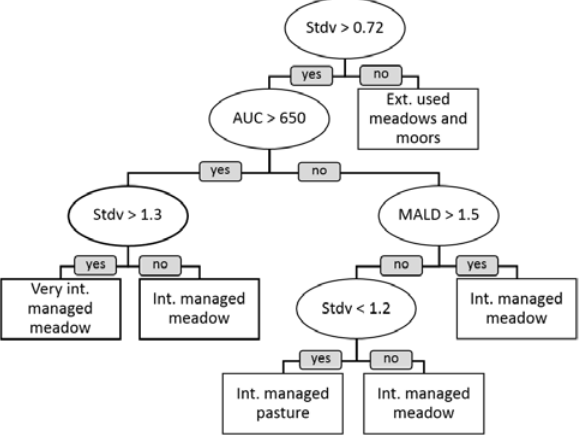
Figure 2. Decision tree rule set used for identifying the different grassland management